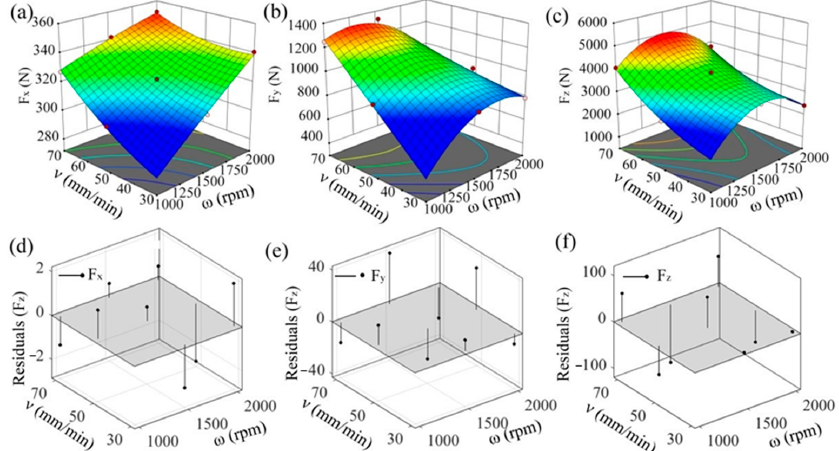
Figure 7. Response surface of welding process parameters and the three forces of the spindle: ( a ) F x , ( b ) F y , and ( c ) F z ; Residual plots: ( d ) F x , ( e ) F y , and ( f ) F z .